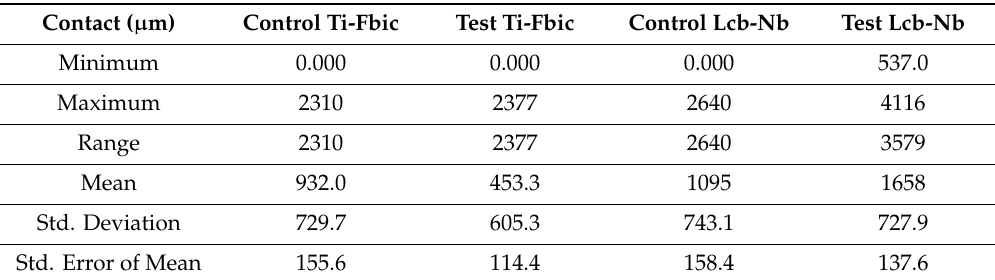
Table 1. Bone tissue in contact with the implant surface, in the cortical portion.